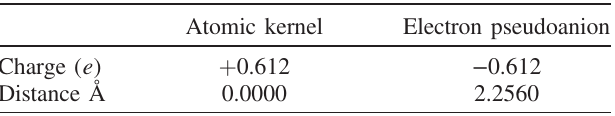
TABLE I. The electric charge of the atomic kernel and an electron pseudoanion in 50 GPa sc Ca calculated by Bader charge analysis [58]. This suggests a high localization of valence electrons in the interstitial